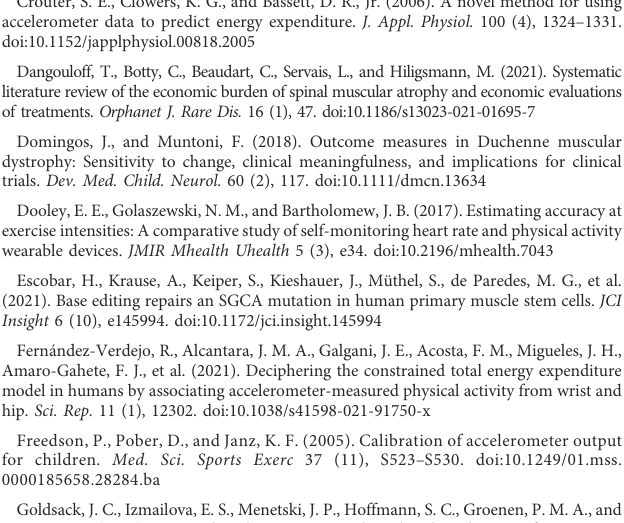
SUPPLEMENTARY FIGURE S3 Patients in the orientation phase provided feedback of their suMus experiences ( n = 27). Their responses were collected via an optional, anonymised online- survey after they used the platform three months. SUPPLEMENTARY FIGURE S4 Movement data obtained during the four exercises. Plotted are the device ’ s acceleration measured in increments of the gravitational acceleration, with the value 1 representing an acceleration of 9.8 m per second in the given direction of the watch. In addition, we recorded the rotation rate in radians per second around the device ’ s three primary